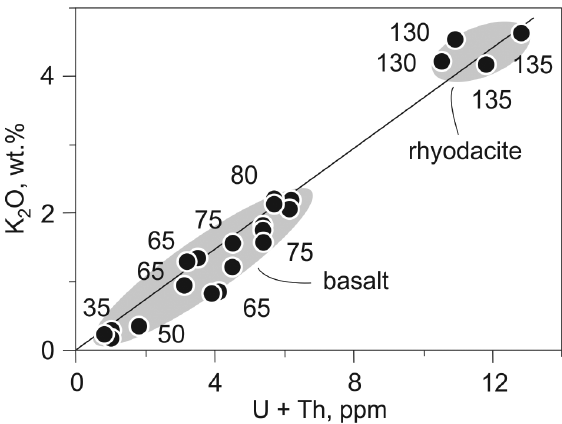
Figure 6 - Diagram displaying the positive correlation between the contents of k Cps values indicated (e.g.,